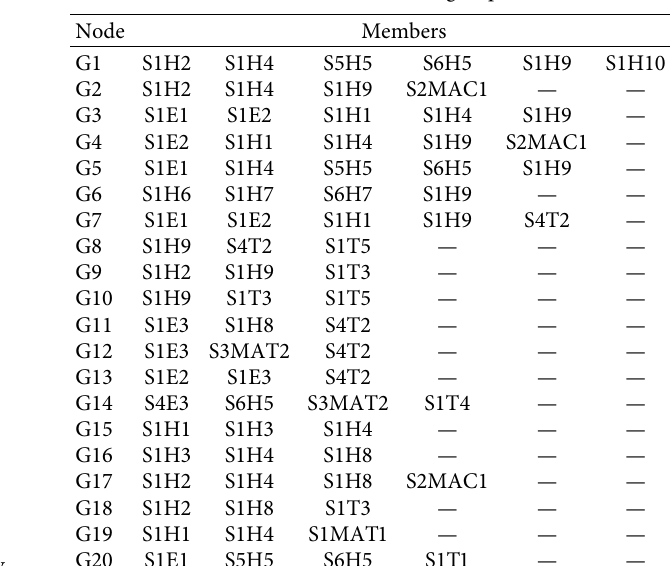
Table 10: Cohesive